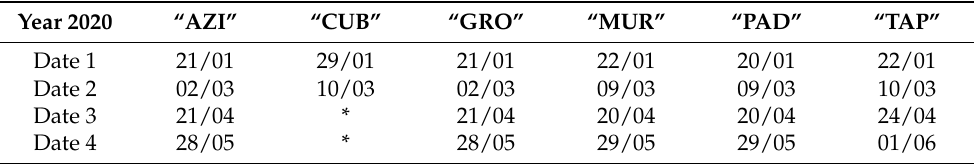
Table 2. Dates of pasture and NDVI sampling in each of experimental fields used in this